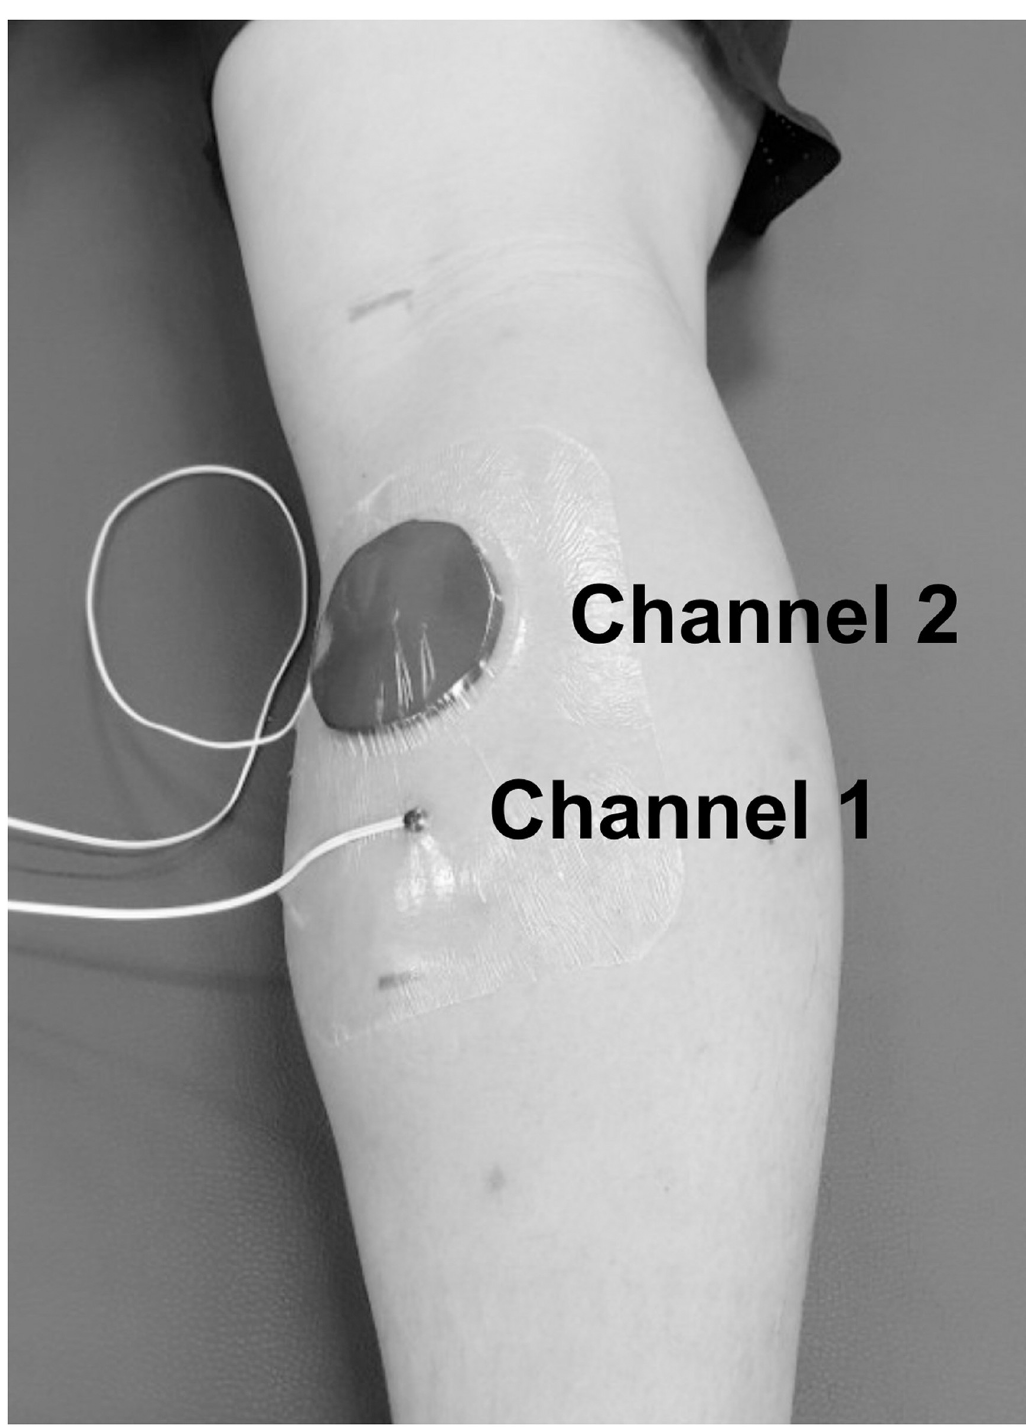
Fig 3. Lower-leg temperature measurements. The thermistor probes were attached to the lower-leg (Channel 1: skin temperature, Channel 2: muscle temperature).